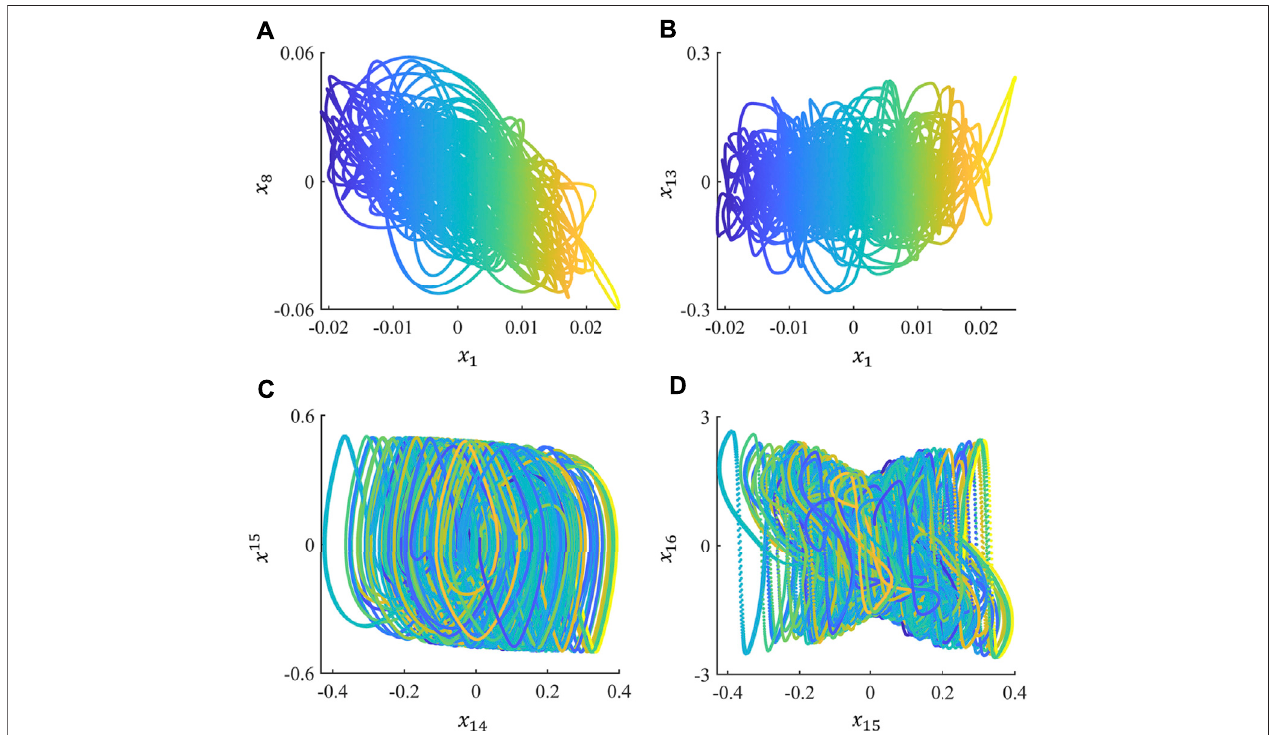
FIGURE3| phasespaceplots: (A) ,thephasespaceplotof x 1 - x 8 plane. (B) ,thephasespaceplotof x 1 - x 13 plane. (C) ,thephasespaceplotof x 14 - x 15 plane. (D) , the phase space plot of x 15 - x 16 plane.